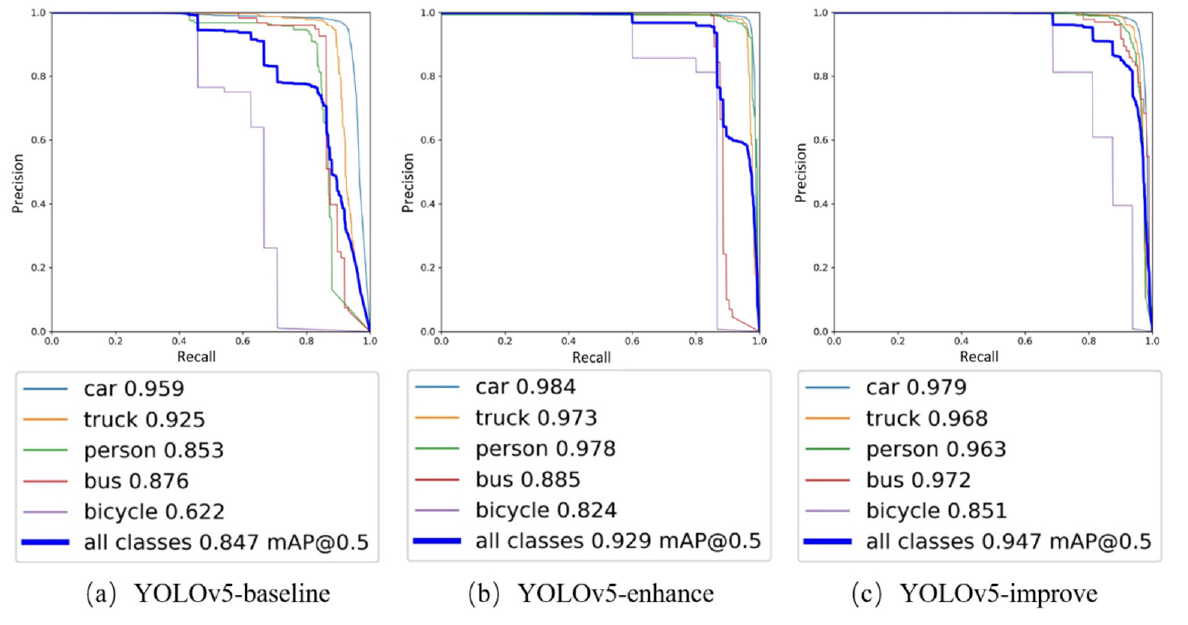
Figure 6. YOLOv5 before and after the improvement of the PR curve comparison chart.